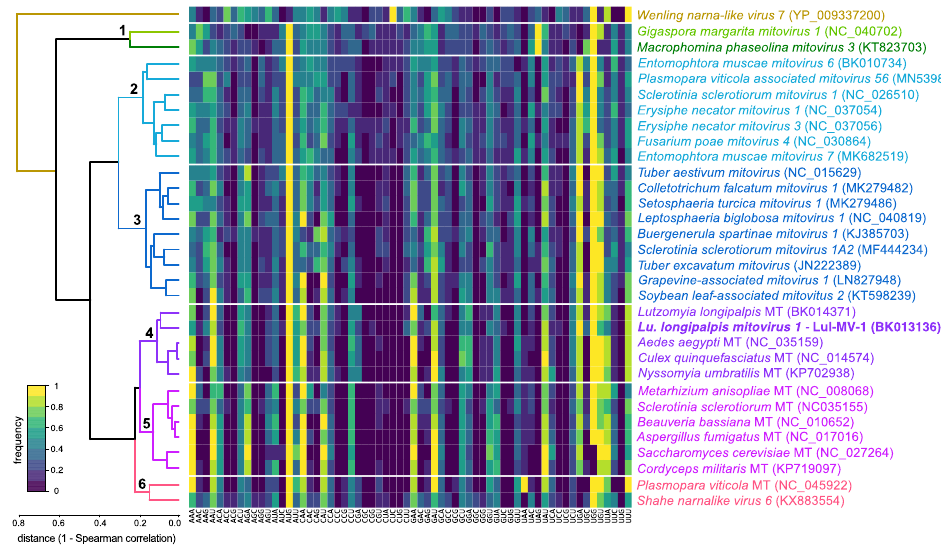
Figure 5. Relationship between codon-usage of mitochondrial viruses and mitochondrial genomes (MT) of putative hosts. Hierarchical clustering of codon usage profiles of viruses and mitochondria of their respective hosts. Clusters were defined by Pearson correlation above 0.8. The numbers indicate the main clades referred in the text.